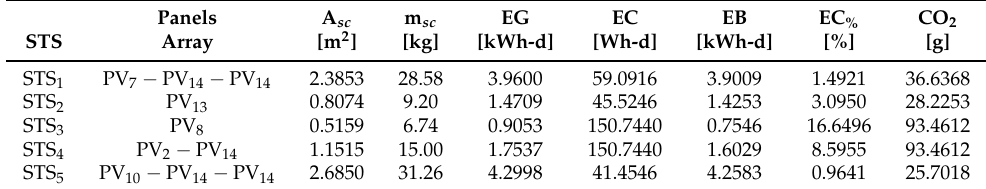
Figure 16. Bar graph of energy analysis of the five solar trackers. Table 11. Summarized results of energy analysis and CO 2 impact